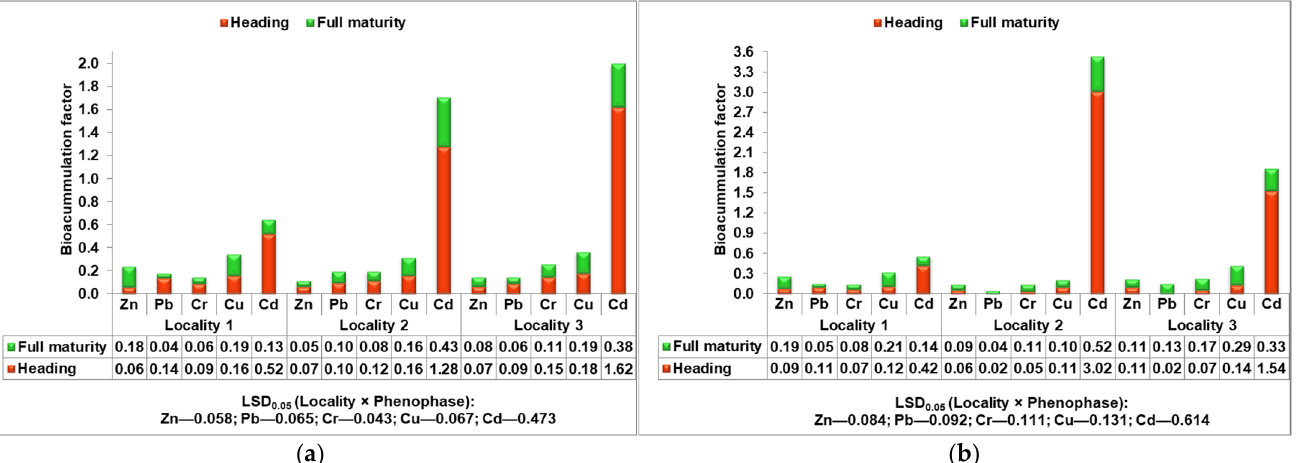
Figure 7. The bioaccumulation factor in the root ( a ) and stem ( b ) in different phenophases of analyzed wheat genotypes.